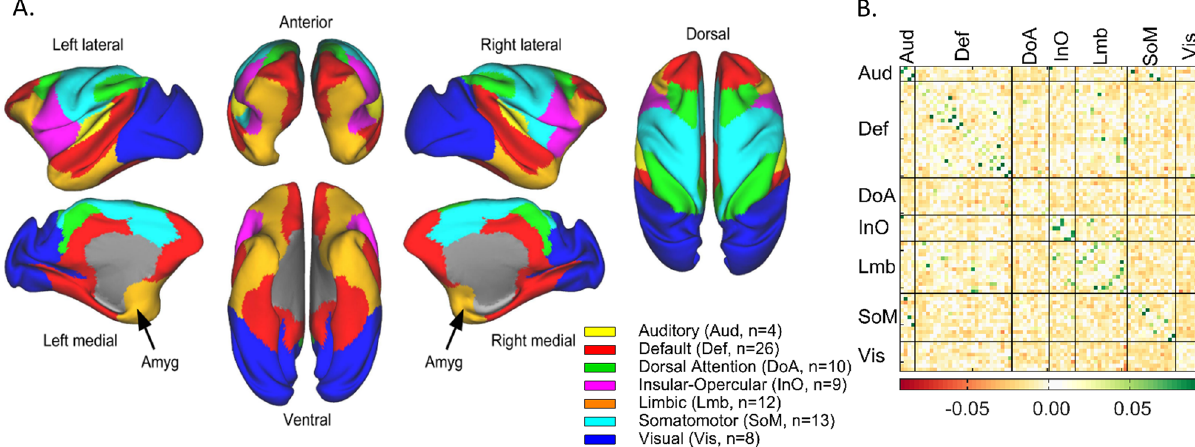
Figure 1. Functional networks and group’s average connectivity matrix. ( A ) Bezgin’s parcellation schema 58 , color-coded by functional network. Color-coded legend also indicates the number of ROIs per network. ( B ) Mean connectivity matrix (n = 63, 3 timepoints from 8 MD, 8 SF and 5 UF macaques) grouped by functional networks.